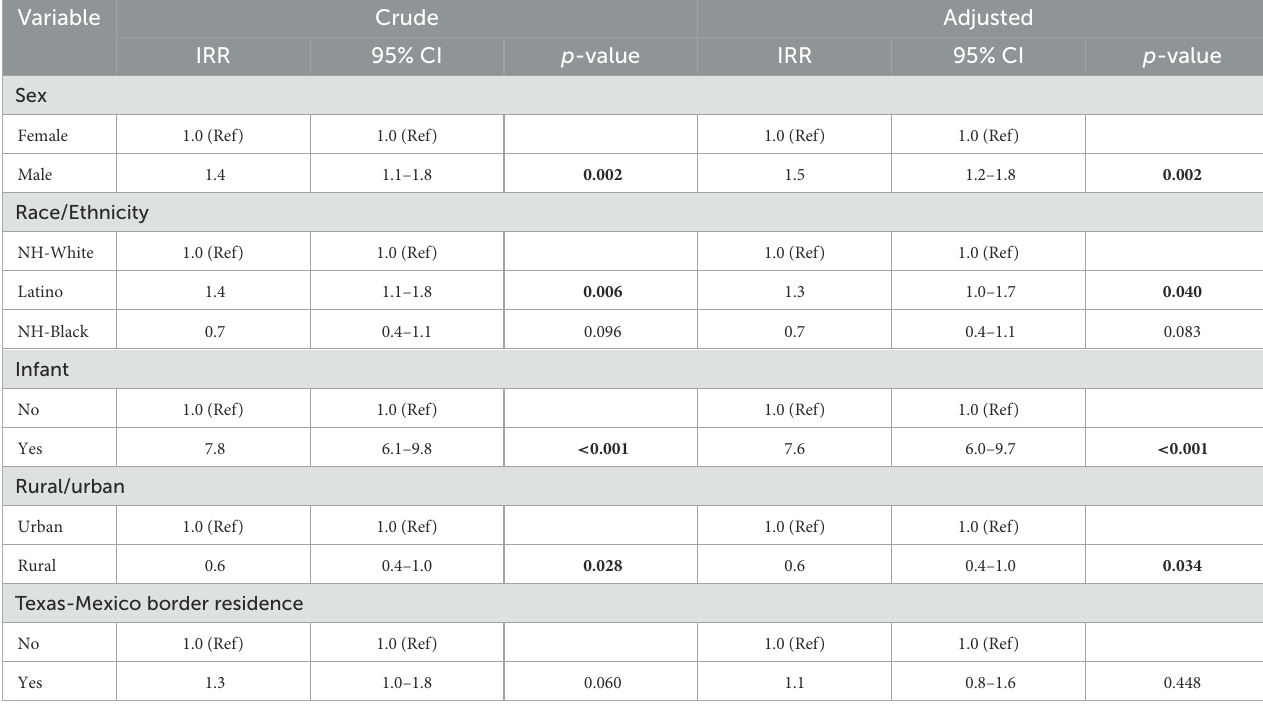
TABLE 2 Association between demographics characteristics and incidence of hepatoblastoma overall in Texas, 1995–2018. Variable Crude